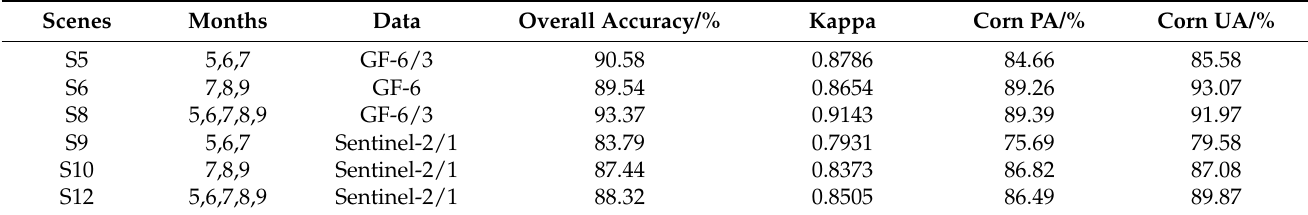
Table 6. Classification results of Chinese GF series and Sentinel series images.